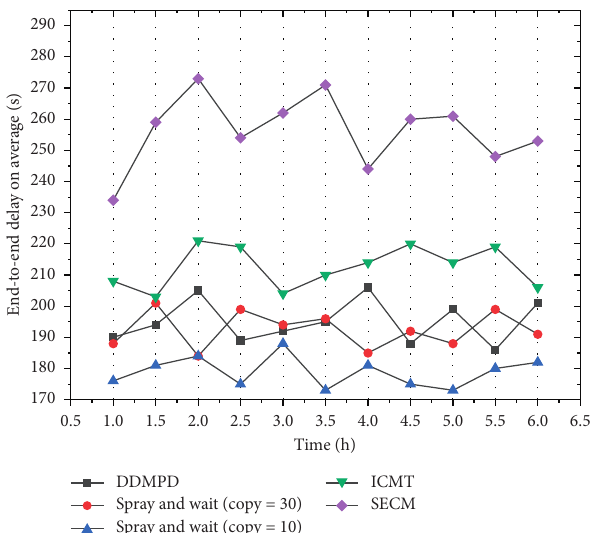
Figure 10: Relationship between end-to-end delay on average and